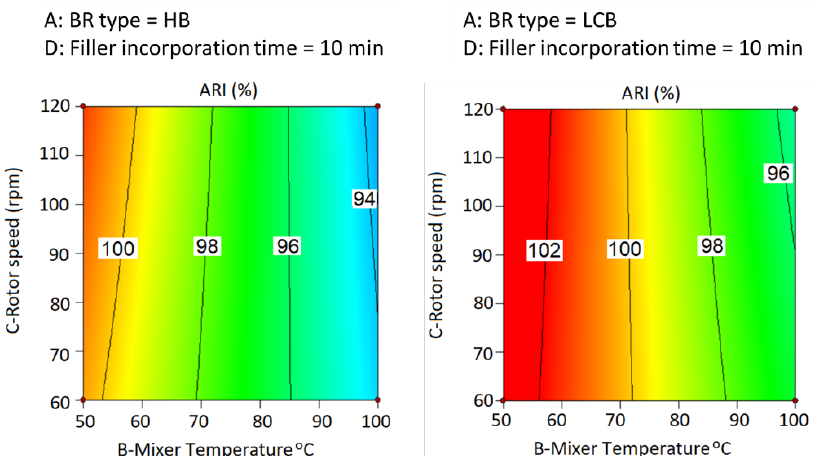
Figure 12. The effect of mixer temperature and rotor speed on ARI in rubber compounds containing HL-BR and LCB-BR.